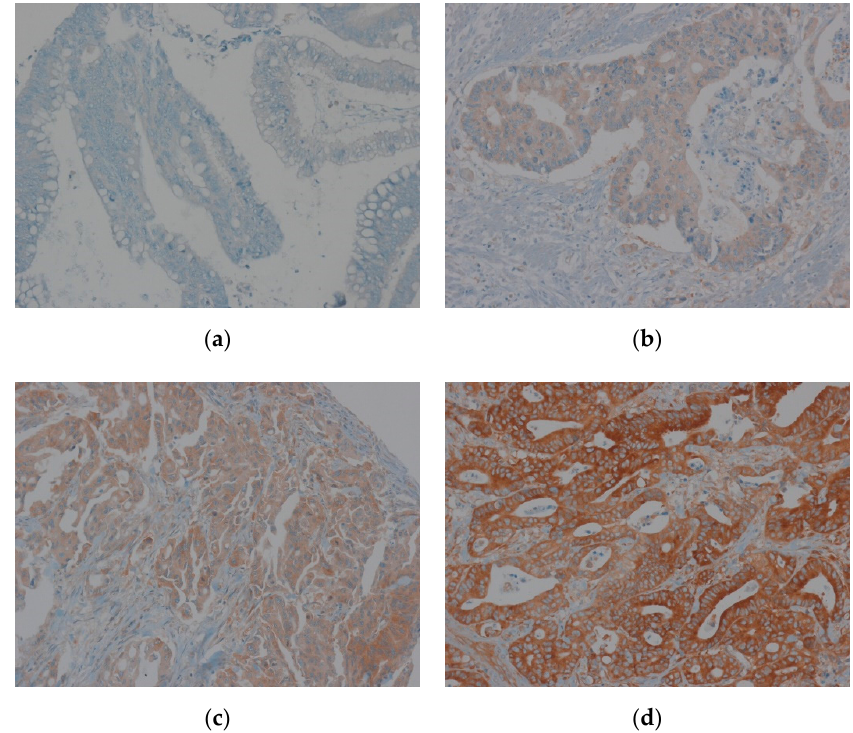
Figure 1. Immunohistochemical staining of elongation factor-1 alpha 1 (EEF1A1) in colon adenocarcinoma tissue. ( a ) Staining intensity 0; ( b ) staining intensity 1; ( c ) staining intensity 2; ( d ) staining intensity 3.